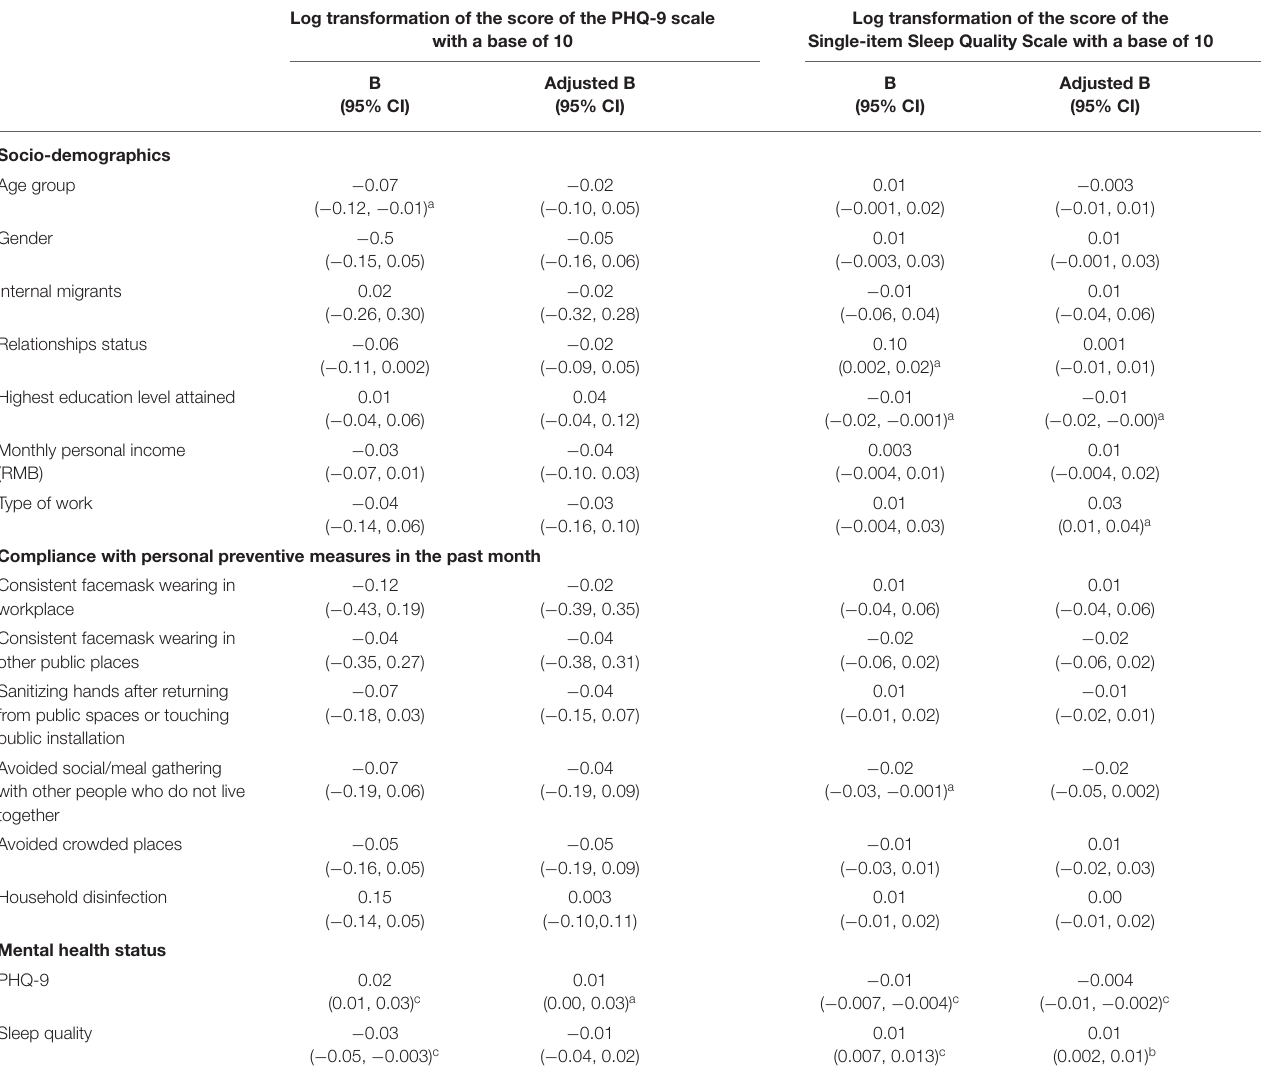
TABLE 4 | Baseline factors predicting depressive symptoms and sleeping quality at Month 3 (results of univariate and multivariate multilevel linear regression models; level 1: factories; level 2: individual participants). Log transformation of the score of the PHQ-9 scale Log transformation of the score of the with a base of 10 Single-item Sleep Quality Scale with a base of